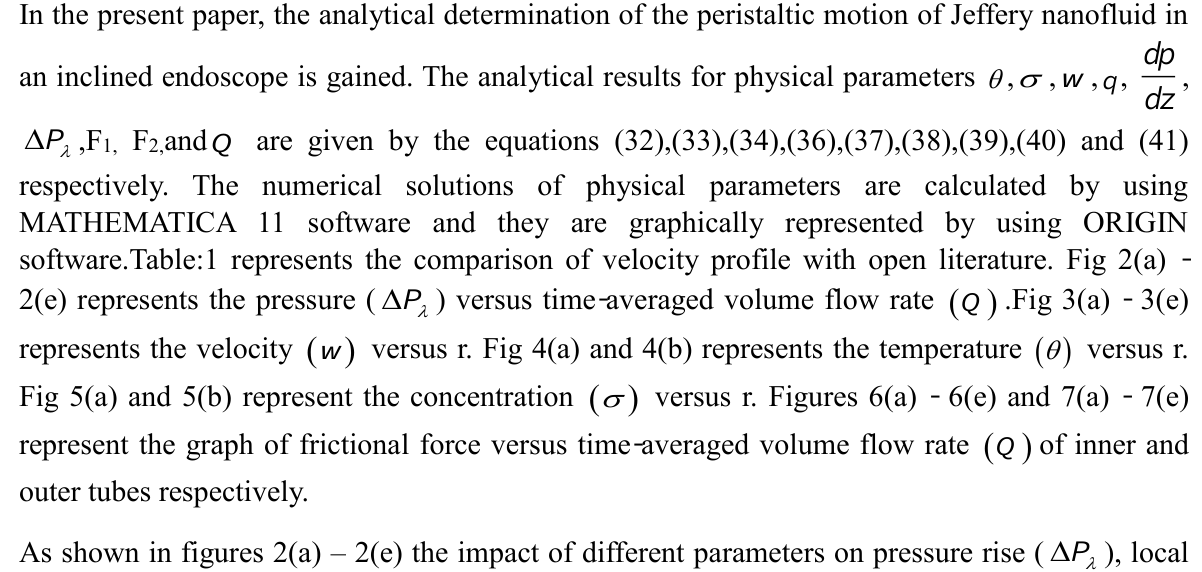
 ) versus time-averaged volume flow rate   Q .Fig 3(a) - 3(e) 2(e) represents the pressure ( P  represents the velocity  w versus r. Fig 4(a) and 4(b) represents the temperature    versus r. Fig 5(a) and 5(b) represent the concentration   versus r. Figures 6(a) - 6(e) and 7(a) - 7(e) represent the graph of frictional force versus time-averaged volume flow rate  Q of inner and outer tubes